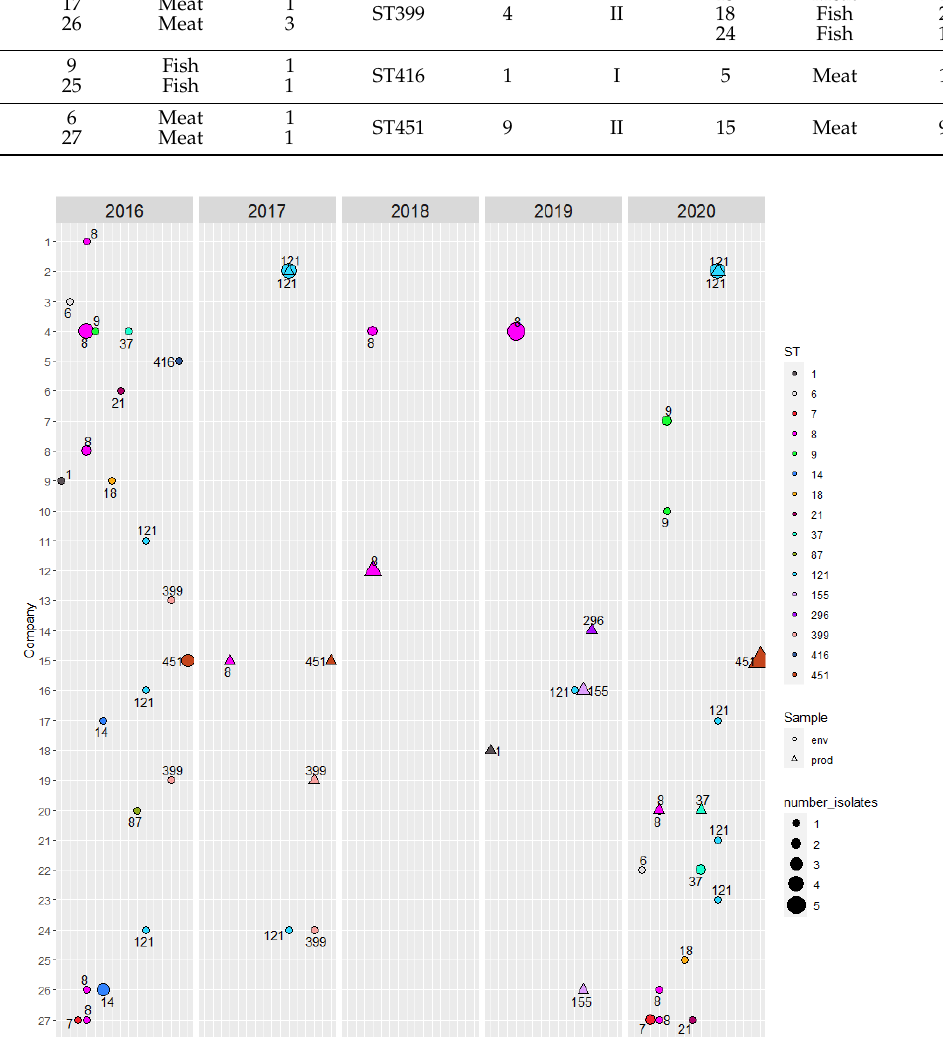
Figure 1. Overview of the number of L. monocytogenes isolates from the participating companies according to different STs and sampling year. Only the companies (27/53) that harboured at least one positive isolate either in product (prod) or environmental (env) samples are shown.